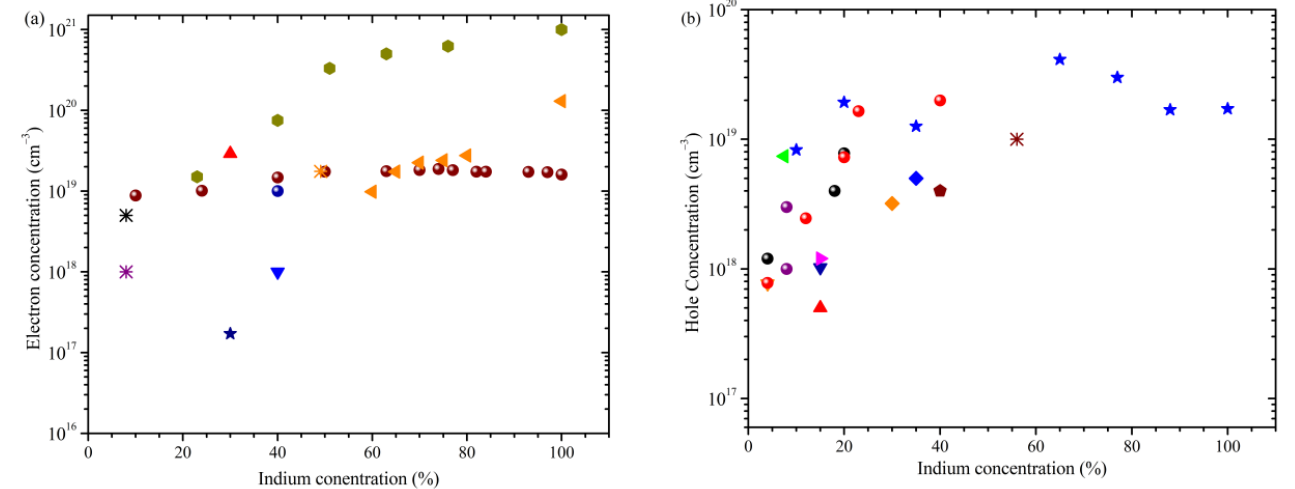
Figure 1. ( a ) Electron concentration as a function of In molar fraction and ( b ) hole concentration as a function of In molar fraction [3,13,18,28,30–33,37–42,44–46,50,51]. Due to the terrestrial applications considered in this work, the appropriate standard solar spectrum is the AM1.5 which corresponds to an Air Mass equal to 1.5 with a zenith angle of around 48.19 ◦ . For the solar spectra AM1.5, the absorption range is considered from 365 nm to 1771 nm (Figure 2), from the maximum available bandgap for x = 0.0, where x is the In molar fraction (GaN at 3.4 eV) up to x = 1, which is the minimum bandgap at